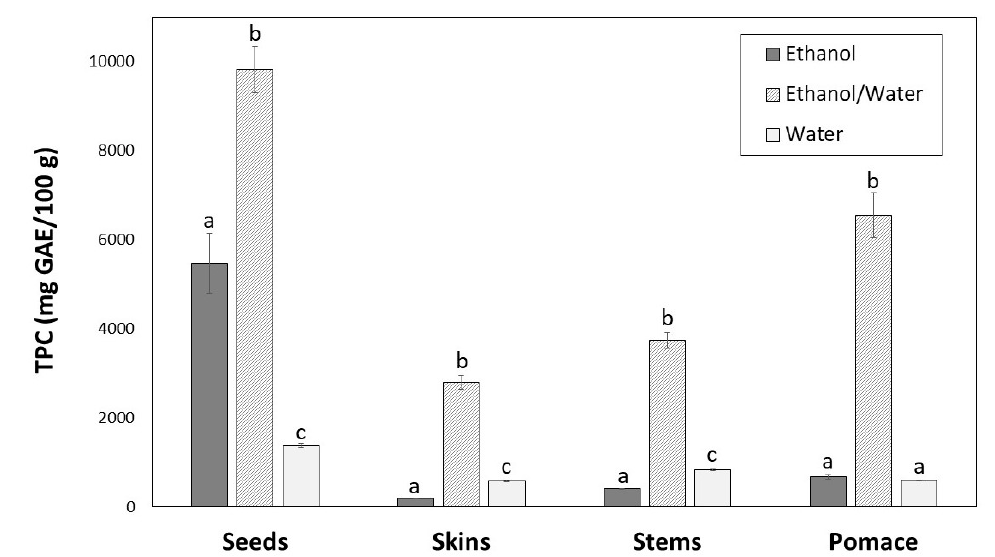
Figure 2. Total phenolic content of seeds, skins, stems and pomace extracts obtained with different solvents. For the same byproduct, different letters indicate significant differences ( p < 0.05) between ethanol, ethanol/water and water extracts by Tukey's test.